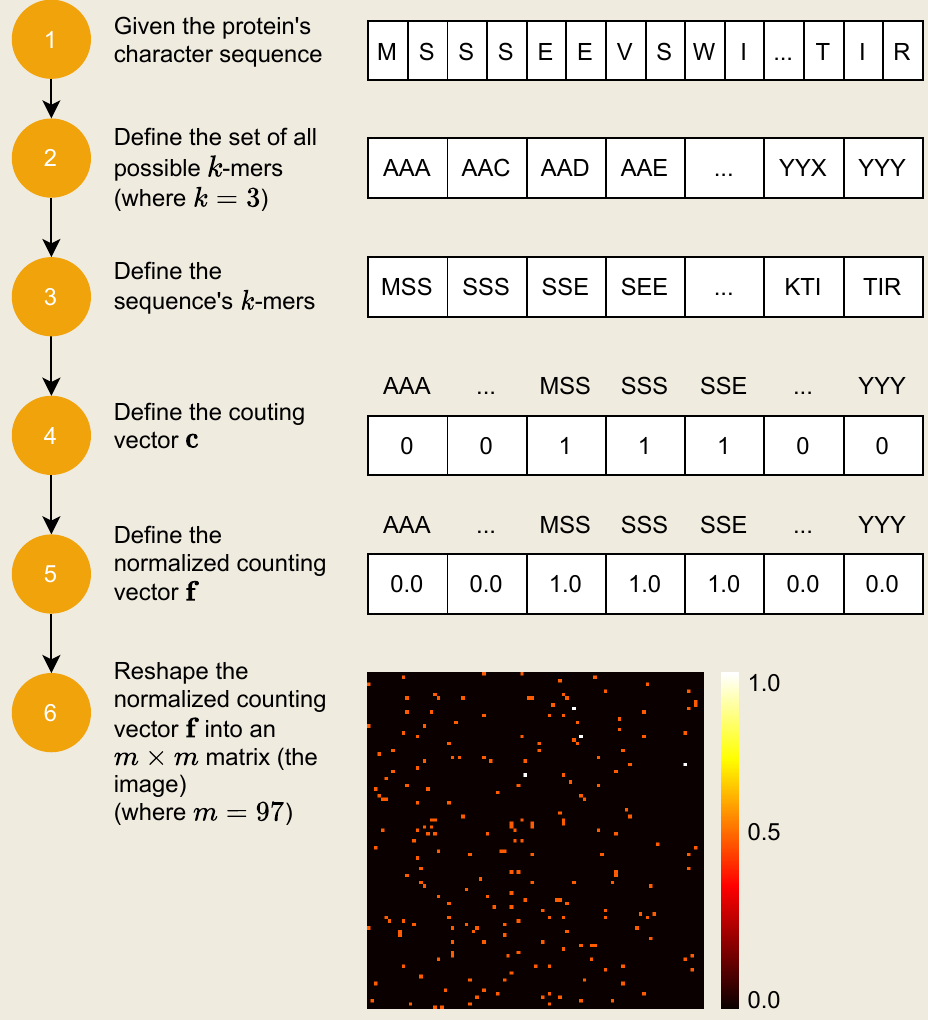
Figure 4. Protein sequence to image